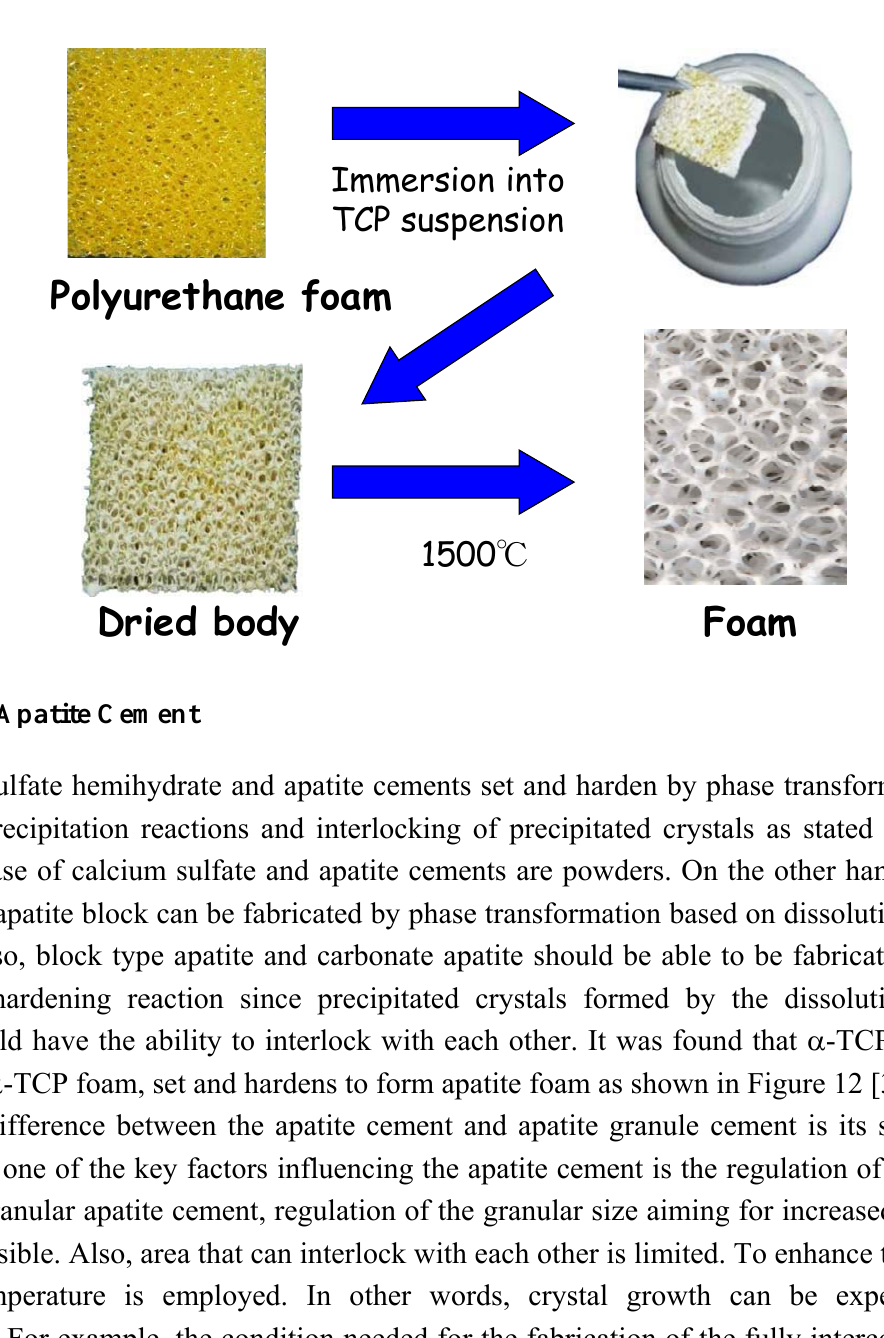
Figure 11. Procedure for the fabrication of α -TCP